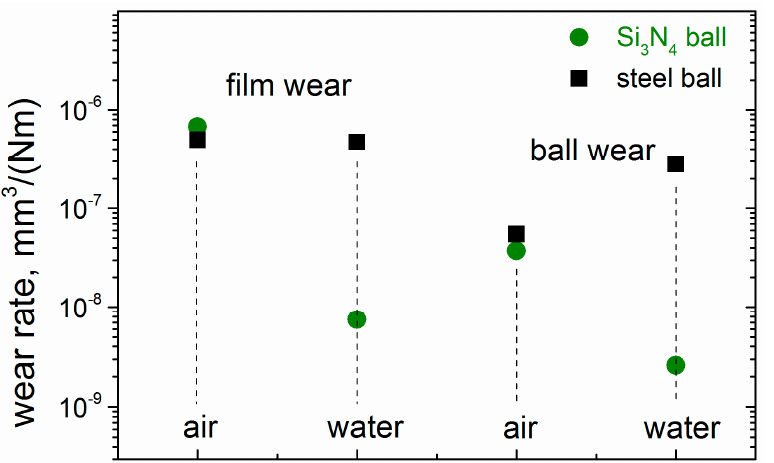
Figure 4. Wear rates of the DLN film and the ball surfaces in humid air and in water, measured after the friction tests shown in Figure 2.